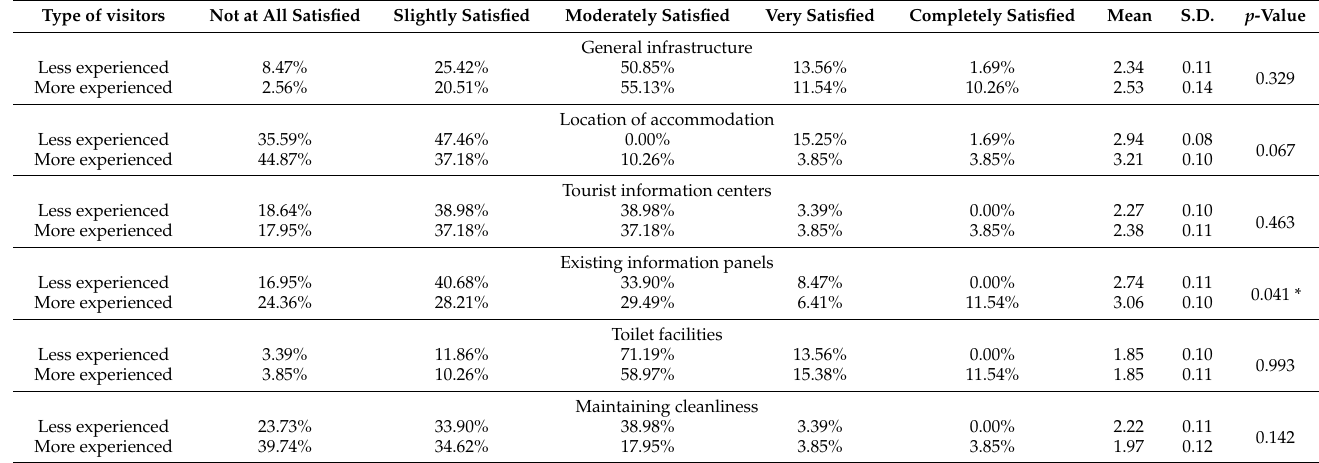
Table 5. Satisfaction regarding the quality of facilities and